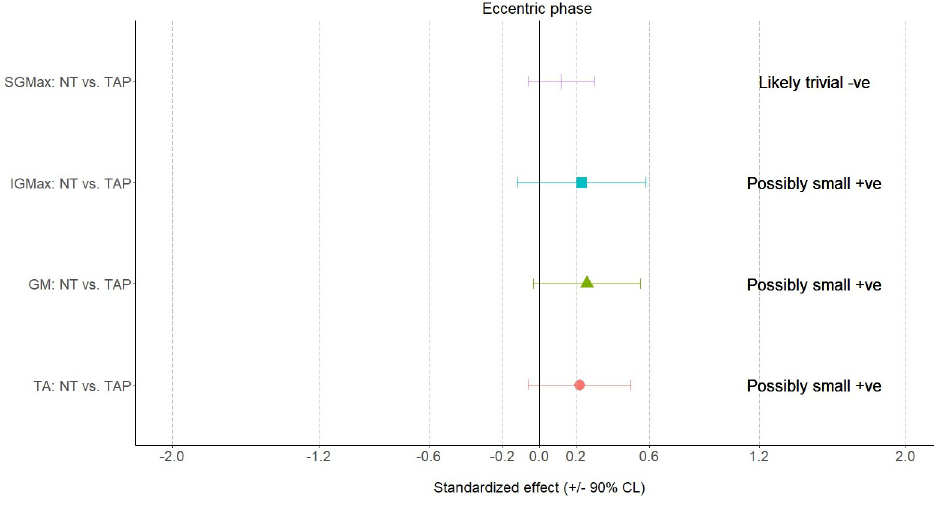
Fig 7. Results of surface electromyography during the eccentric (down) phase of the bilateral squat. NT—non- taped condition; TAP—taped condition; SGMax—superior gluteus maximus; IGMax—inferior gluteus maximus; GM —gluteus medius; TA—tibialis